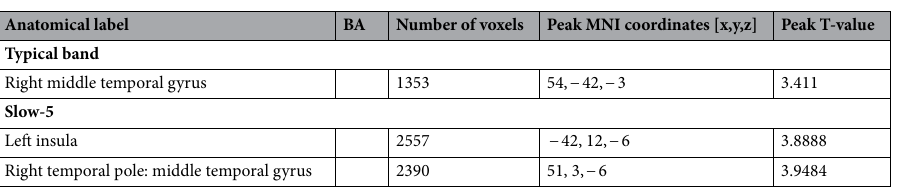
Table 4. Comparisons of Percentage Amplitude Fluctuation between groups in typical low frequency range (0.01–0.08 Hz) and slow-5 frequency bands (GRF Corrected, Overall P < 0.05). All the coordinates are denoted by Montreal Neurological Institute (MNI) space coordinates.